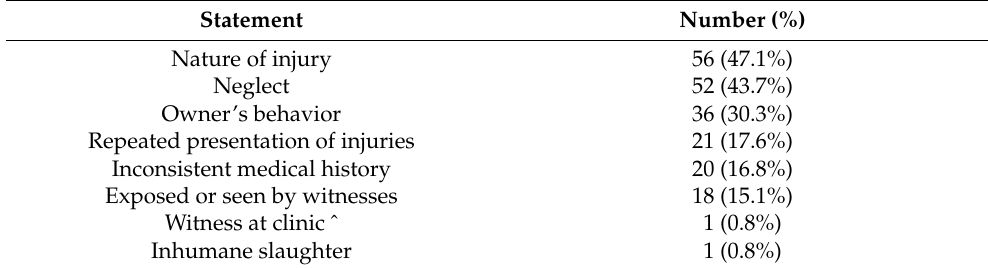
Table 11. Reasons for suspecting the case to be physical animal abuse. Multiple choices were allowed for this question. This was an open-ended question, and the respondents could add options themselves. The results were calculated only from the answers of 119 veterinarians who claimed they had the knowledge to identify physical abuse, or who had encountered abuse